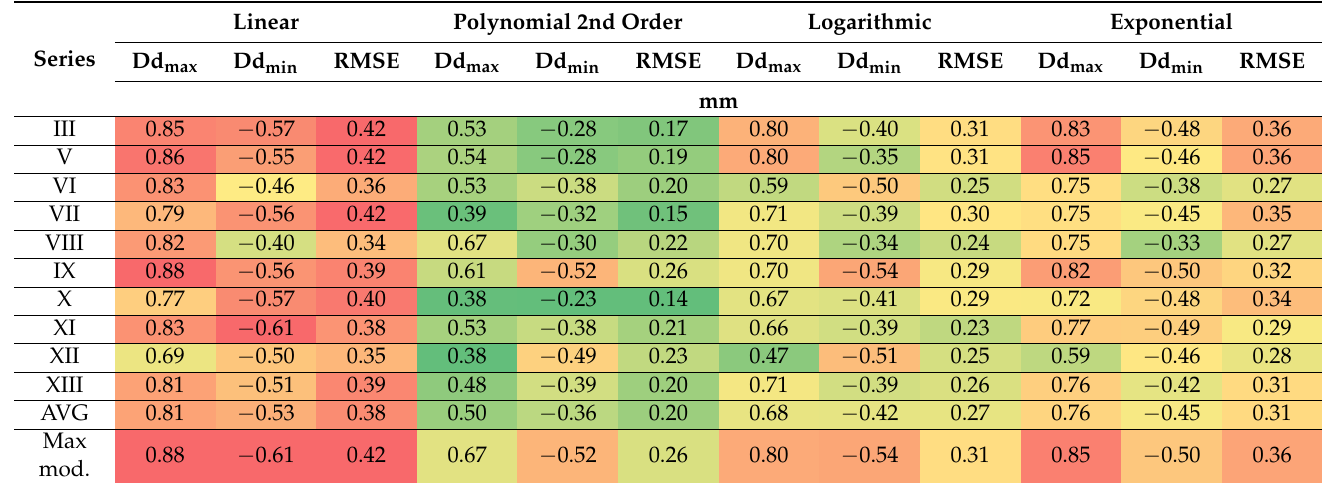
Table 3. Limit errors of approximation ˆ d and RMSE for the four approximation methods.